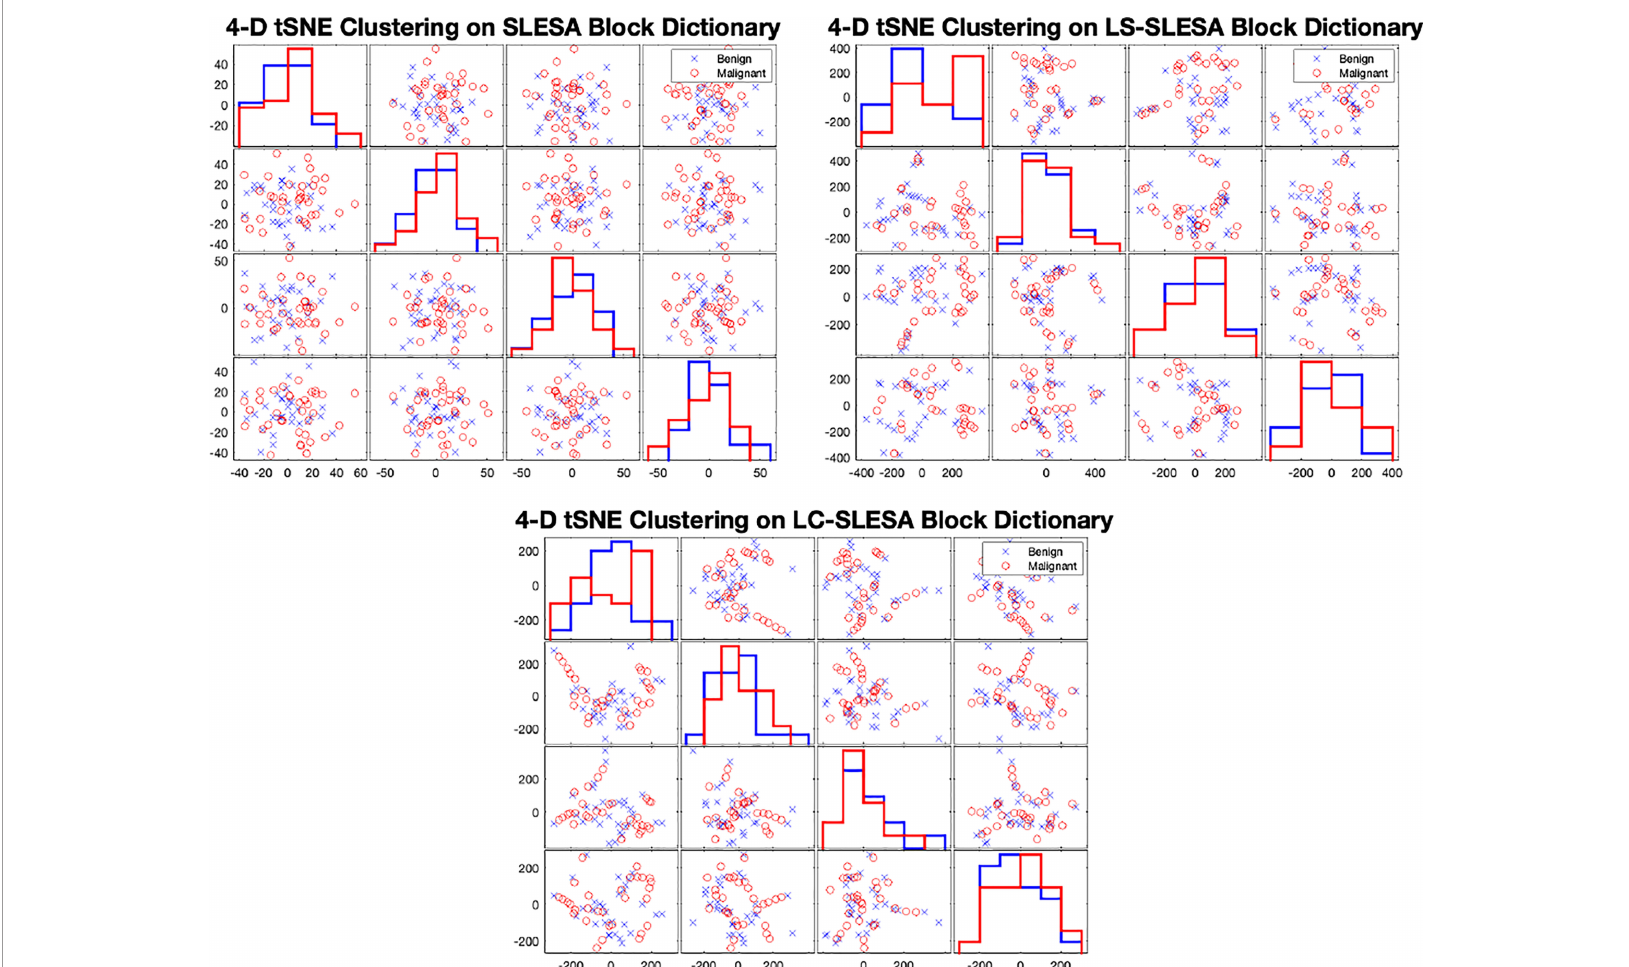
FIGURE 7 | t-SNE clustering plots with 4-D embedding of block dictionaries produced by SLESA (top-left), LS-SLESA (top-right), and LC-SLESA (bottom). The greatest KL divergence for SLESA is 3.9353 produced by the fi rst feature. The greatest KL divergence for LS-SLESA is 4.7651 produced by the third feature. The greatest KL divergence for LC-SLESA is 4.7252 produced by the fi rst